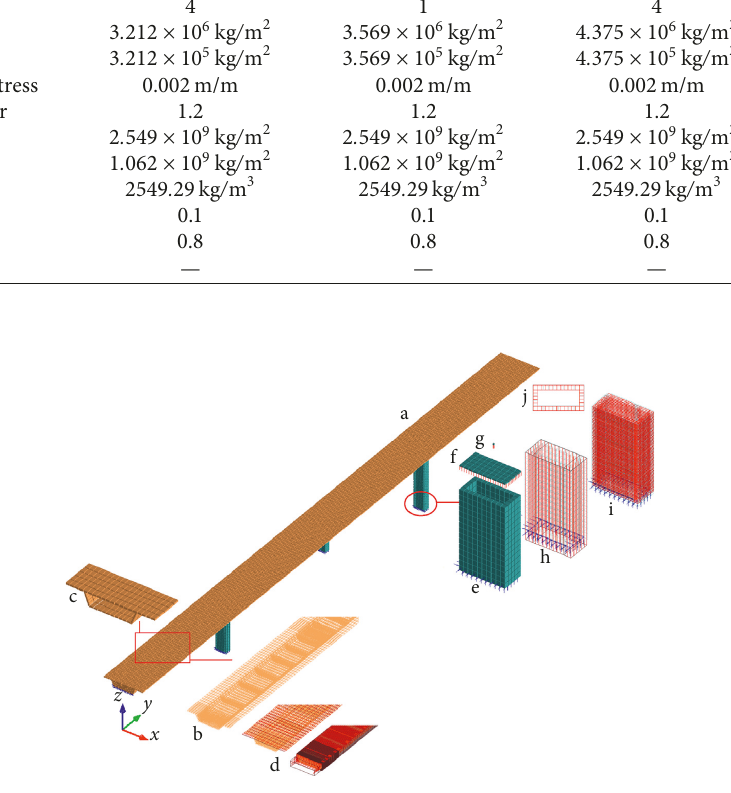
Figure 6: Bridge model in AEM: (a) hole model of bridge, (b) deck meshing overview, (c) deck section, (d) deck reinforcing, (e) pier section and its meshing details, (f) elastic plate to better load distribution on pier, (g) pin element, (h) longitudinal reinforcement, (i) transverse reinforcement, and (j) stirrups details.